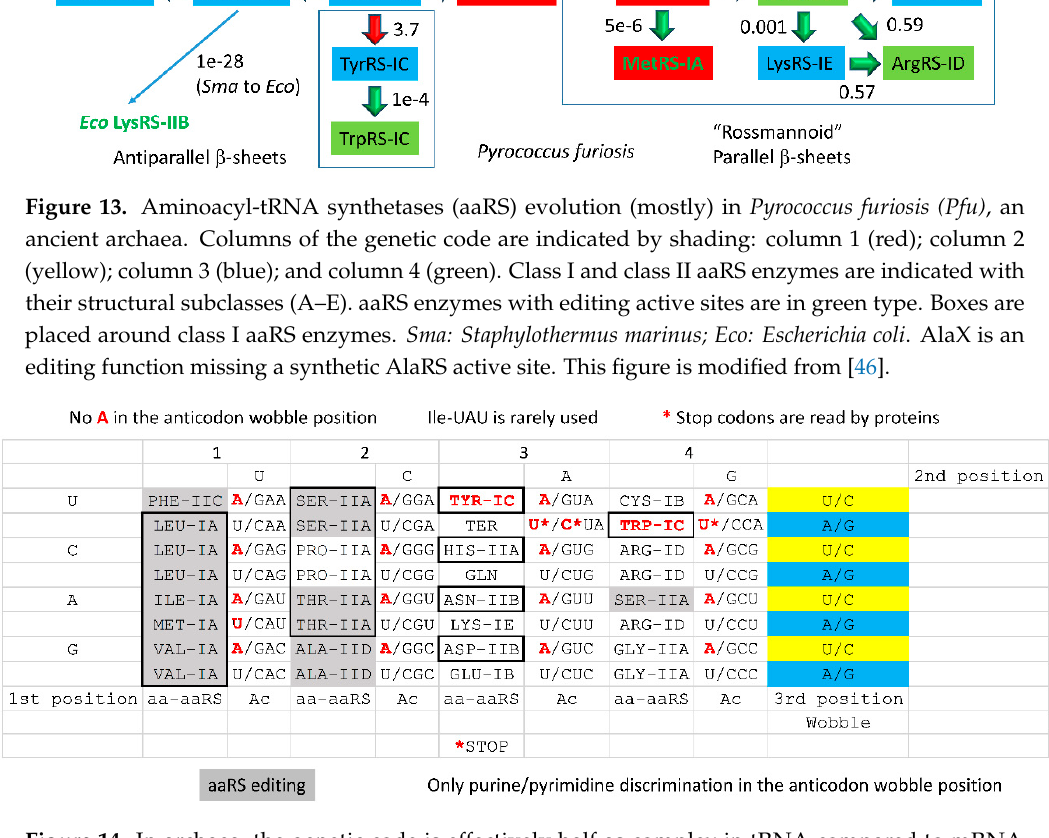
Figure 14. In archaea, the genetic code is effectively half as complex in tRNA compared to mRNA. The genetic code is shown as a codon-anticodon (Ac) table. The structural classes of aaRS enzymes are indicated (i.e., GlyRS-IIA is indicated as GLY-IIA). Grey shading indicates aaRS editing. Red bases are not utilized in the tRNA anticodon wobble position. Boxes indicate co-evolution of amino acids and aaRS enzymes in columns. TyrRS-IC and TrpRS-IC (boxed) are related across rows. Significantly, only pyrimidine/purine discrimination is achieved in the wobble position in archaea because of anticodon wobble ambiguity. Ancient archaea tend to have ~44 tRNAs, but tRNA wobble U and C anticodons are effectively synonymous.